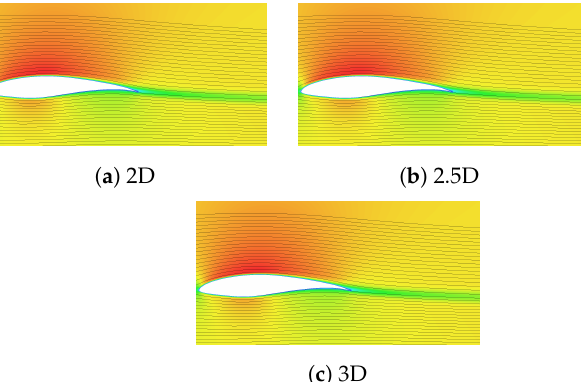
Figure 8. HAWT–S826: Illustration of error for 2D, 2.5D and 3D geometric approximations simulated under similar conditions. The flow patterns indicate strong two-dimensional flow at the outer section of blade. Note: the velocity magnitude is restricted to 0–1 m/s to provide better contrast.